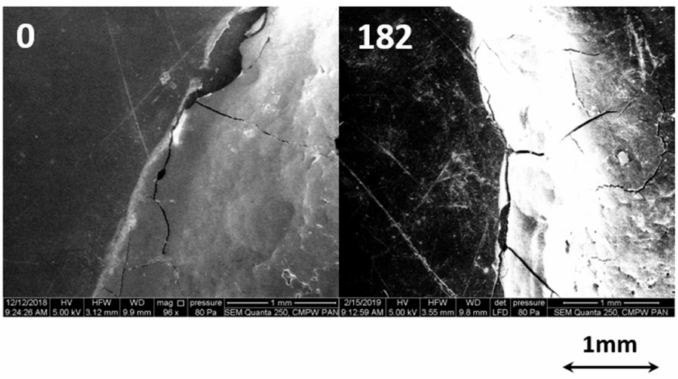
Figure 7. SEM images (96 × ) of the surface of PHA 3 before and after 182 days of incubation in water at 70 ◦